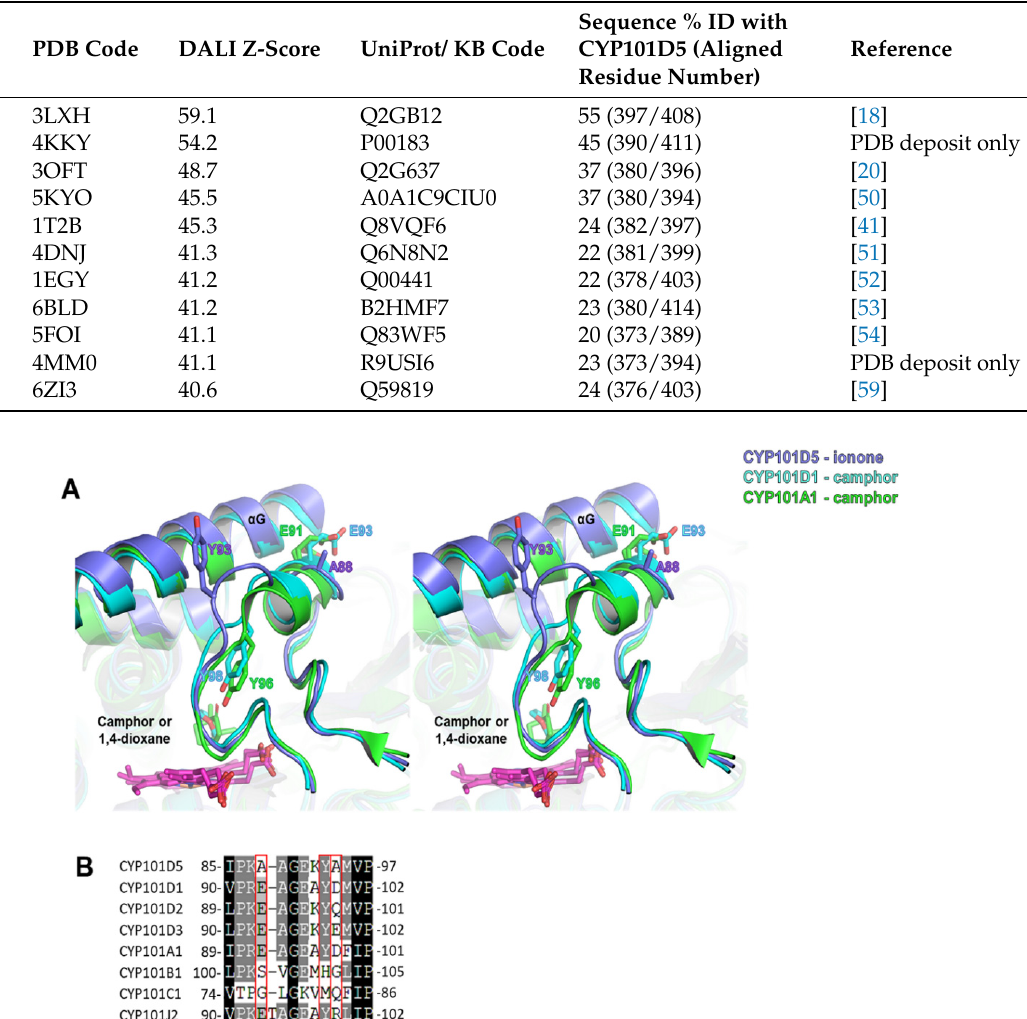
Figure 6. Structural and sequence comparison of the B/C region. ( A ) Stereo view of the CYP101D5 structure overlaid with structurally similar CYP101D1 (PDB: 3LXH) and CYP101A1 (PDB: 4KKY). α F, α G, and the B/C loop are shown with sticks, and the 1,4-dioxane from CYP101D1 and camphor from CYP101A1 are indicated with sticks at the substrate binding site. ( B ) Sequence alignment of the B/C loop region and amino acids. Residues corresponding with the Tyr93 of CYP101D5 and small residues on the B/C loop, which are specific to CYPs with substrate preference for ionone, are marked with red boxes.